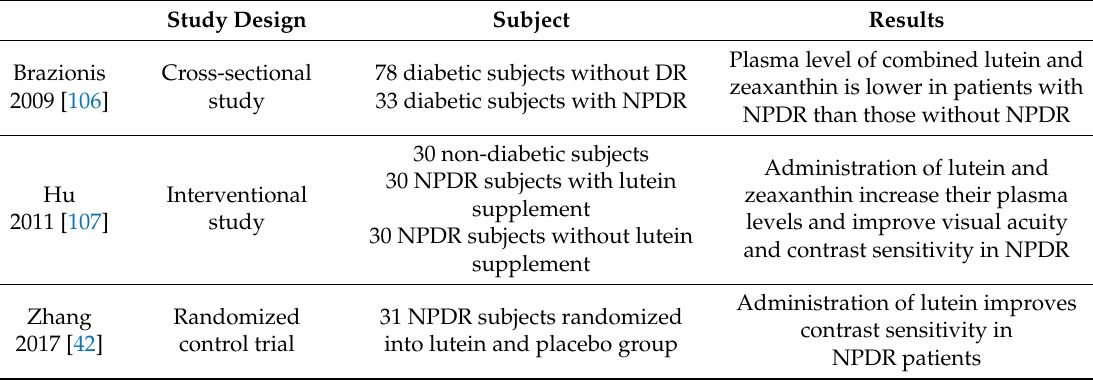
Table 8. Studies showing the association between blood lutein level and DR